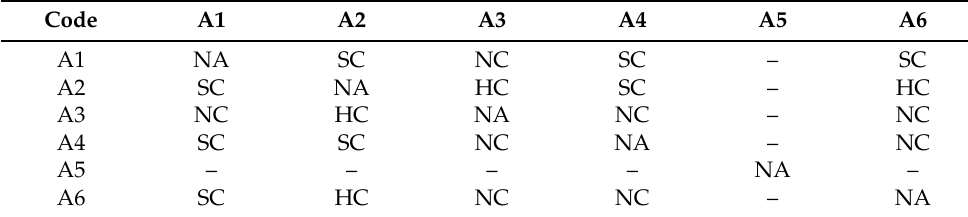
Figure 6. Normal probability plot of gold grade by type of alteration. Table 4. Contact analysis of Au (ppm) by type of